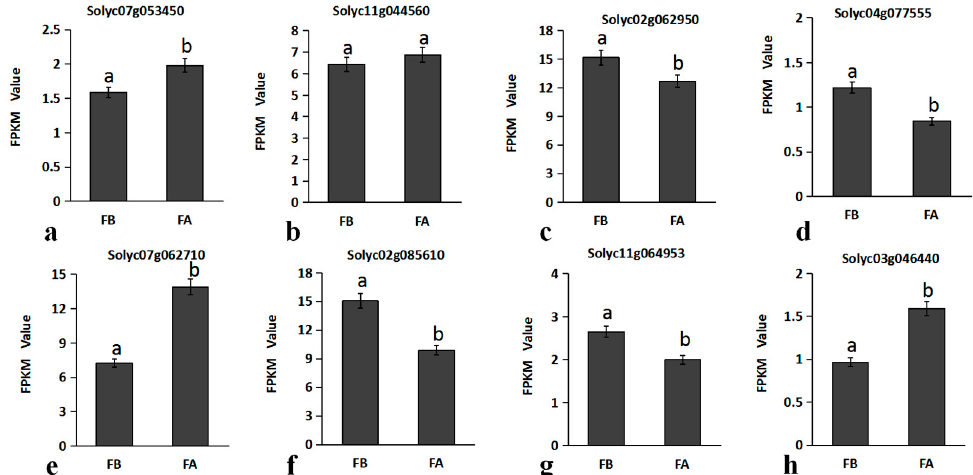
Figure 9. Comparative analysis of quantitative results of tomato bZIP family genes.FPKM values of eight DEGs were obtained by RNA-seq. Error bars indicate the standard deviation. p < 0.05 indicates a significant difference: a is significantly higher than b, and a significant difference between the same letters. Note: FB: flower bud; FA: full-bloom stage. Different letters indicate significant differences at the p < 0.05 level. Subgraphs ( a – h ) correspond to the relative expression comparison of the selected eight bZIP genes in different periods